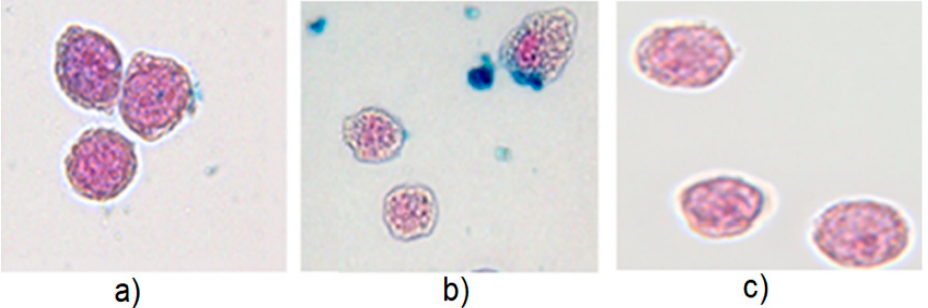
Figure 4. Light microscopy images of THP-1 monocytes after Prussian blue staining of iron Nuclear Fast Red staining of nuclei. Cells were incubated with ( a ) Syn-COOH in PBS, ( b ) Syn-COOH in RPMI with 10% FCS, and ( c ) SynD-PEG in PBS. The cellular uptake proceeds at an iron concentration of 0.5 mmol/L and incubation time of 15 min.